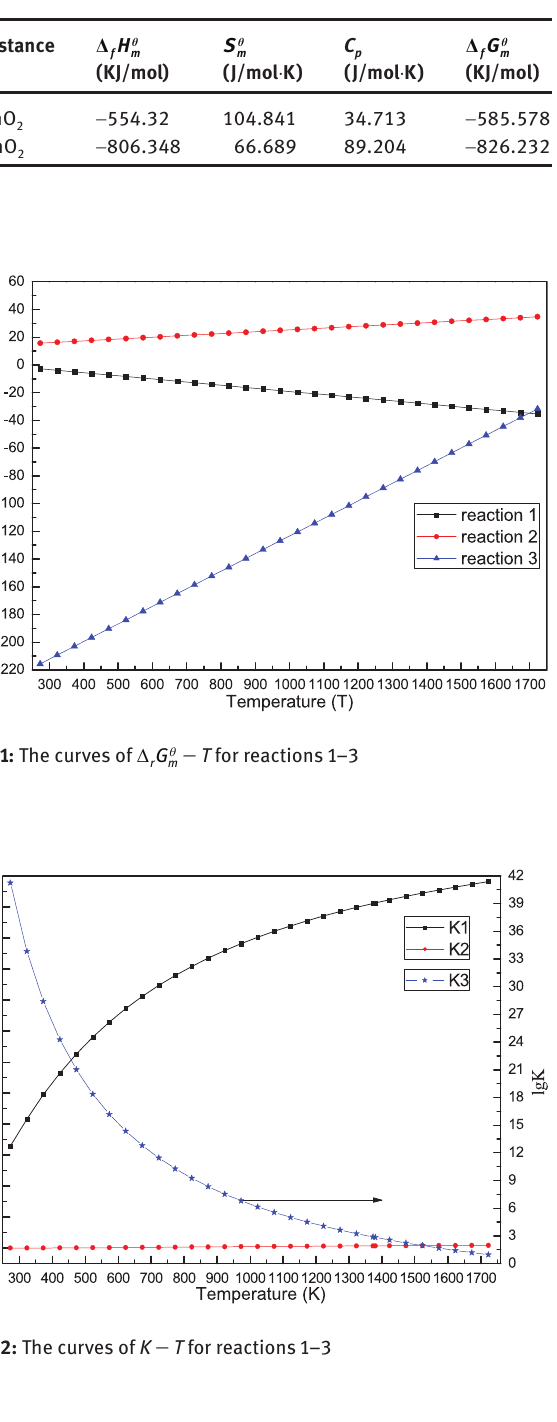
Table 6: Reaction formulas, standard thermodynamic data at 298 K and lg K − 1/ T Eq. No.